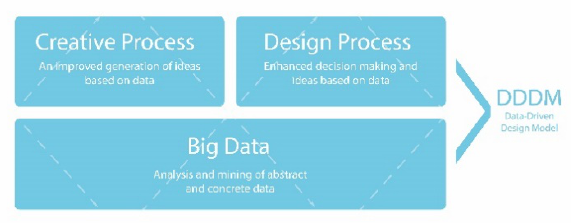
Fig. 3: Creative process and design process integration with Big